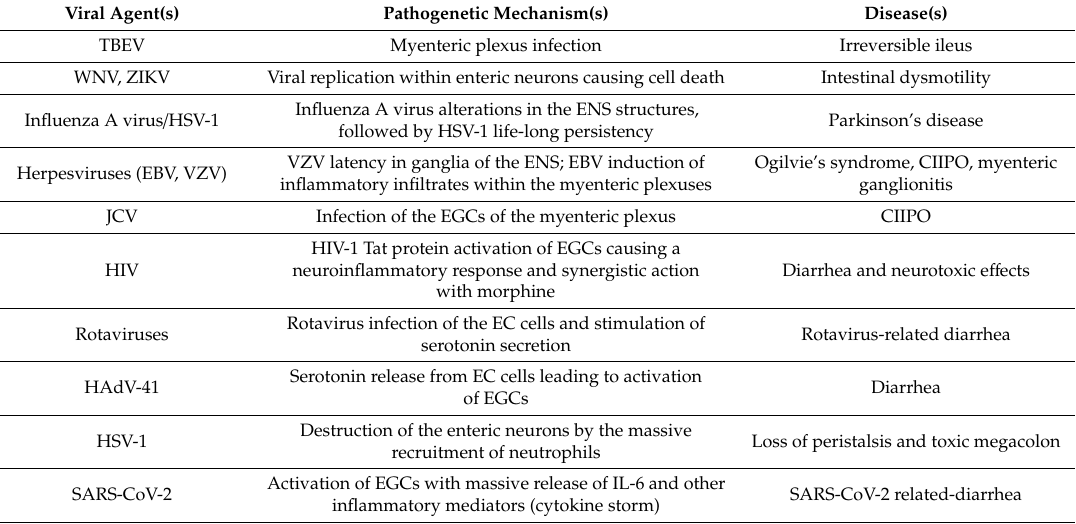
Table 2. Viruses and the enteric nervous system.